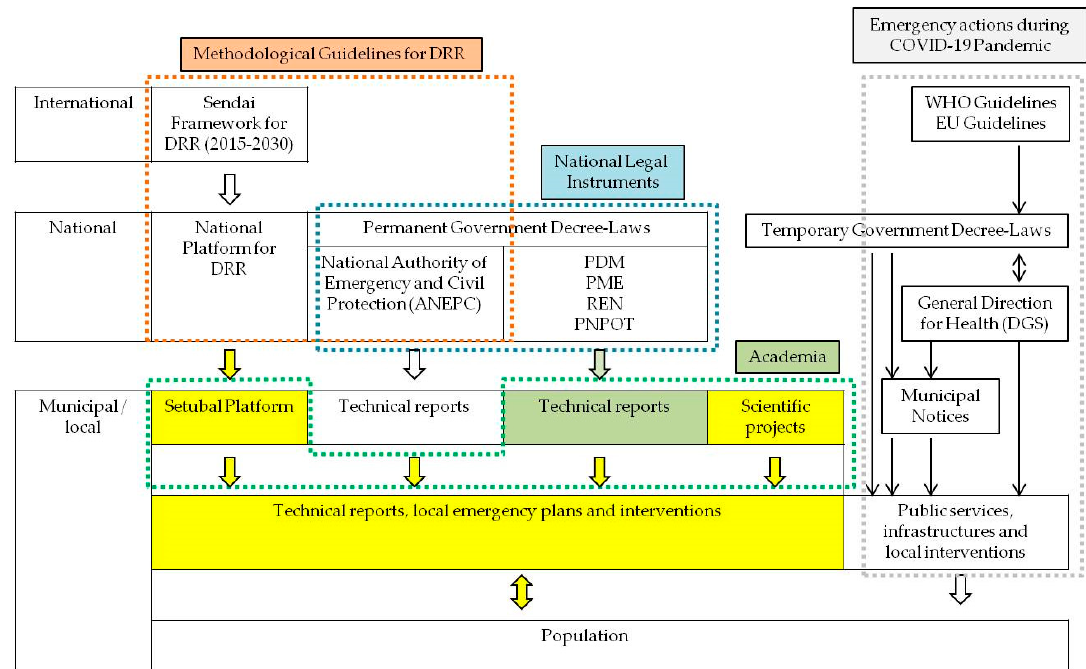
Figure 2. Schematic tools to cope with natural disasters and the current COVID-19 pandemic at international, national and the municipal / local levels. Highlighted in yellow are the strategy tools created by Setubal municipality.